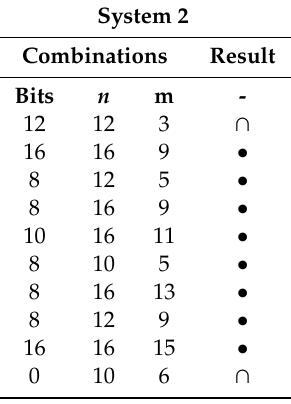
Table 5. Results of multifractal analysis of system 2.